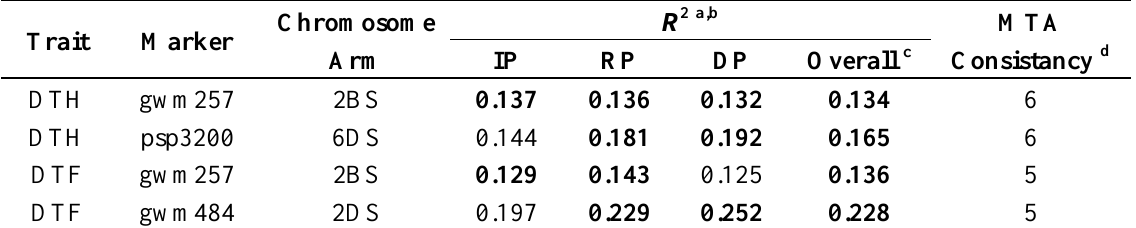
Table 5. Association of SSR markers with agronomic traits and drought